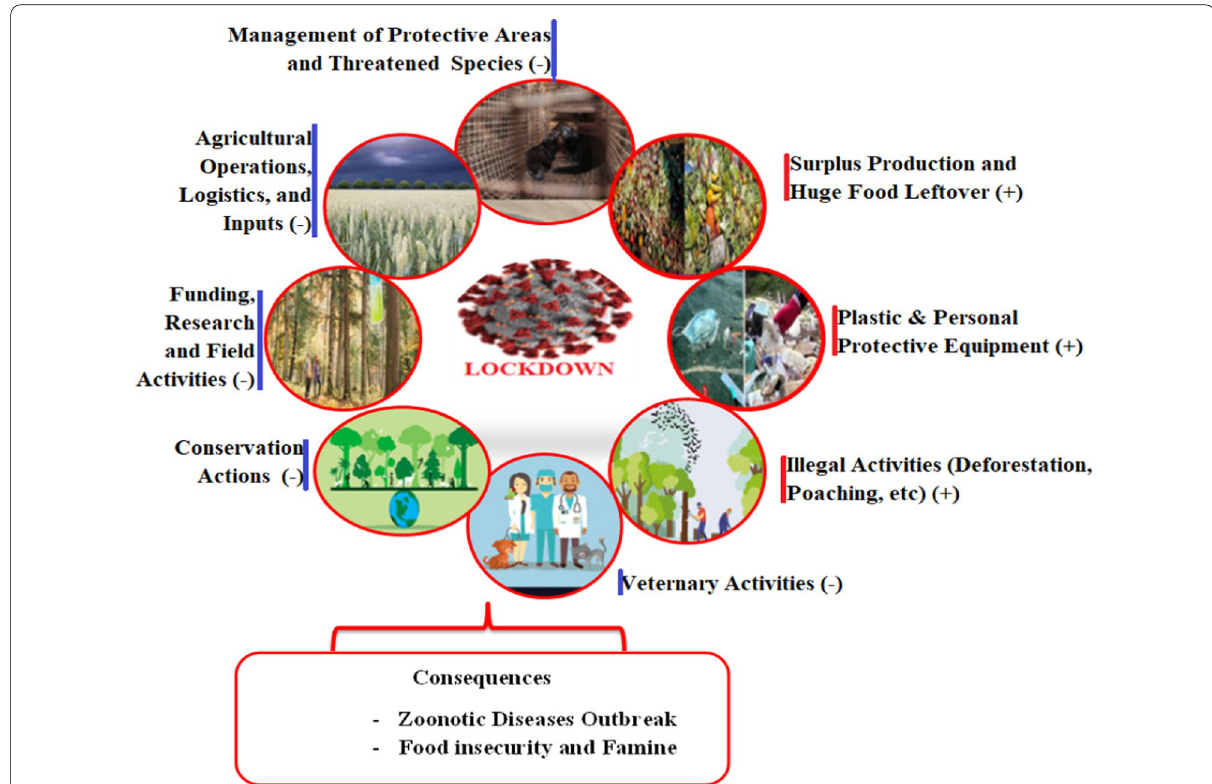
Fig. 2 The negative effect of COVID-19 lockdown on environmental management and biodiversity management operations, ( increasing trends and ( ) reduction in −